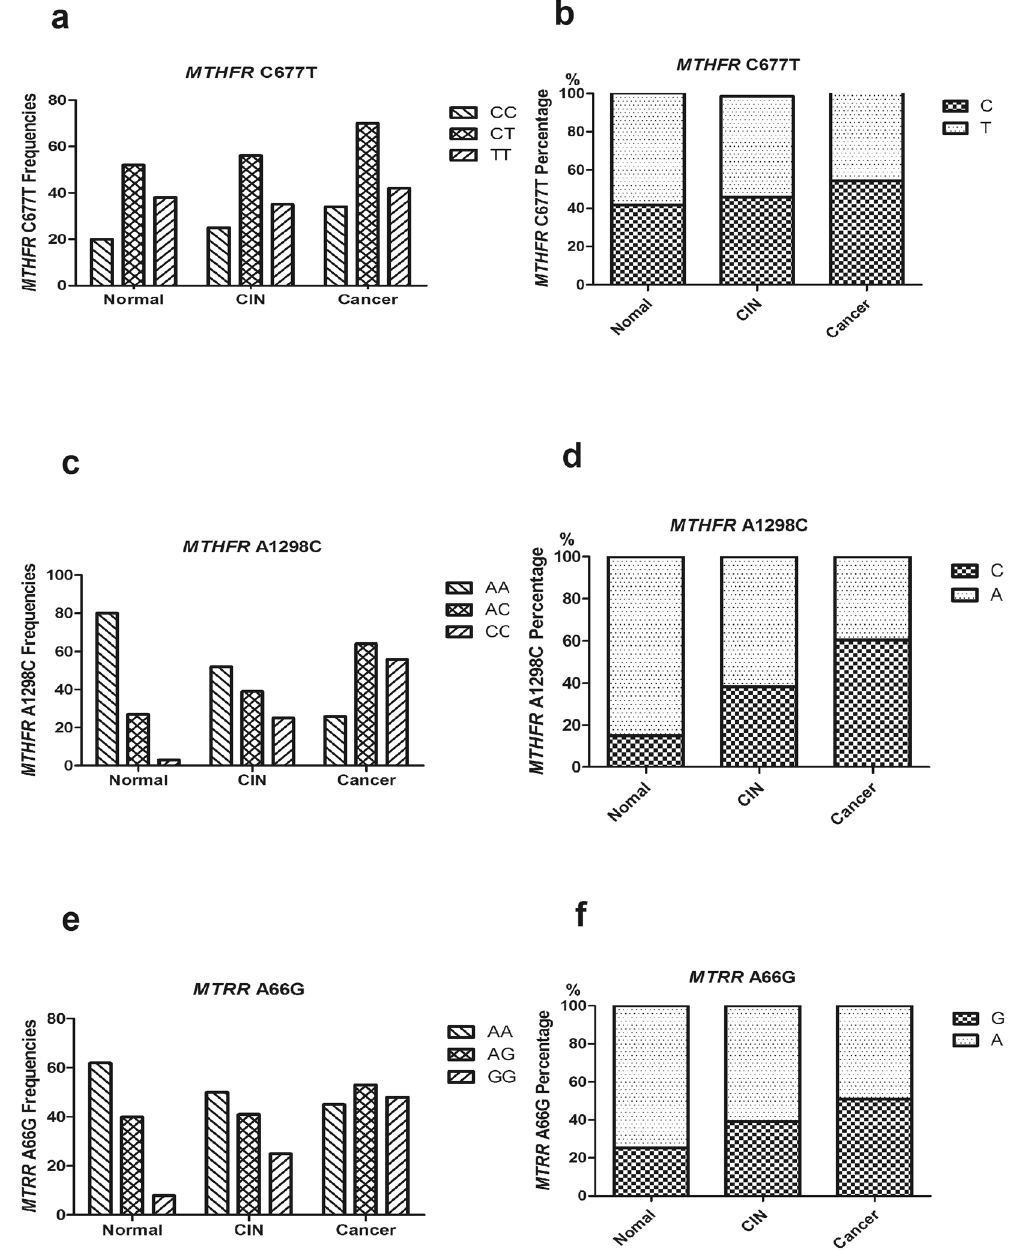
Figure 2. Distribution of MTHFR C677T, A1298C and MTRR A66G allele frequencies. ( a ) the frequencies of CC, CT and TT genotype in MTHFR C677T in normal group, CIN group and cancer group, respectively, ( b ) the percentage of C and T allele in MTHFR C677T in the three groups, respectively, ( c ) the frequencies of AA, AC and CC genotype in MTHFR A1298C in the three groups, respectively, ( d ) the percentage of A and C allele in MTHFR A1298C in the three groups, respectively, ( e ) the frequencies of AA, AG and GG genotype in MTRR A66G in the three groups, respectively, ( f ) the percentage of A and G allele in MTRR A66G in the three groups,